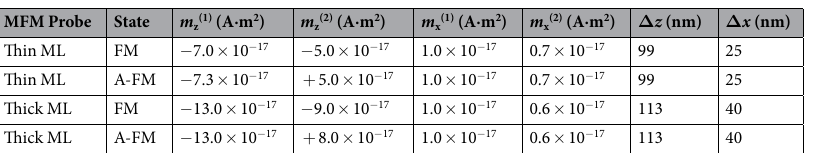
Table 1. z - and x -components ( m z(i) , m x(i) ) of the dipole moments of each individual layer (i = 1, 2) within thin and thick ML-MFM probes and their vertical displacement ( Δ z ). The first five parameters are a result of the fitting procedure, while the horizontal displacement of the two dipoles ( Δ x ) is given by the layer thicknesses.